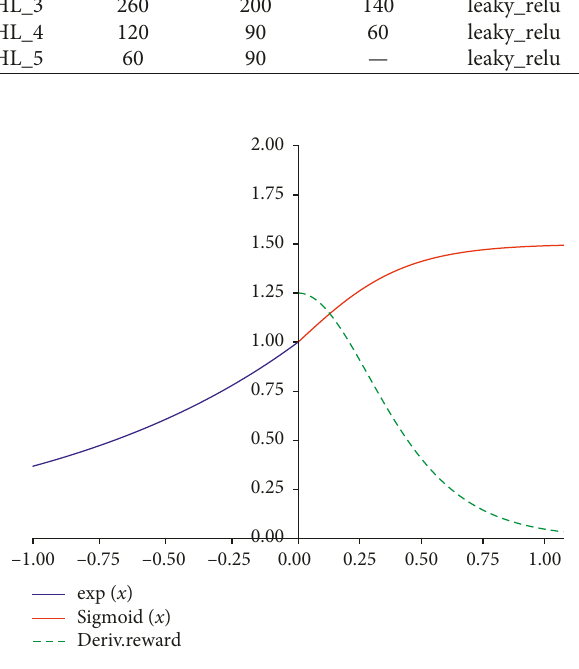
Figure 6: Weighting function